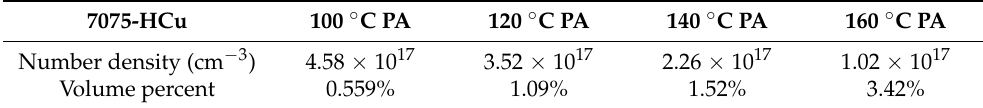
Table 7. Number density and volume percent of 7075-HCu subjected to different PA